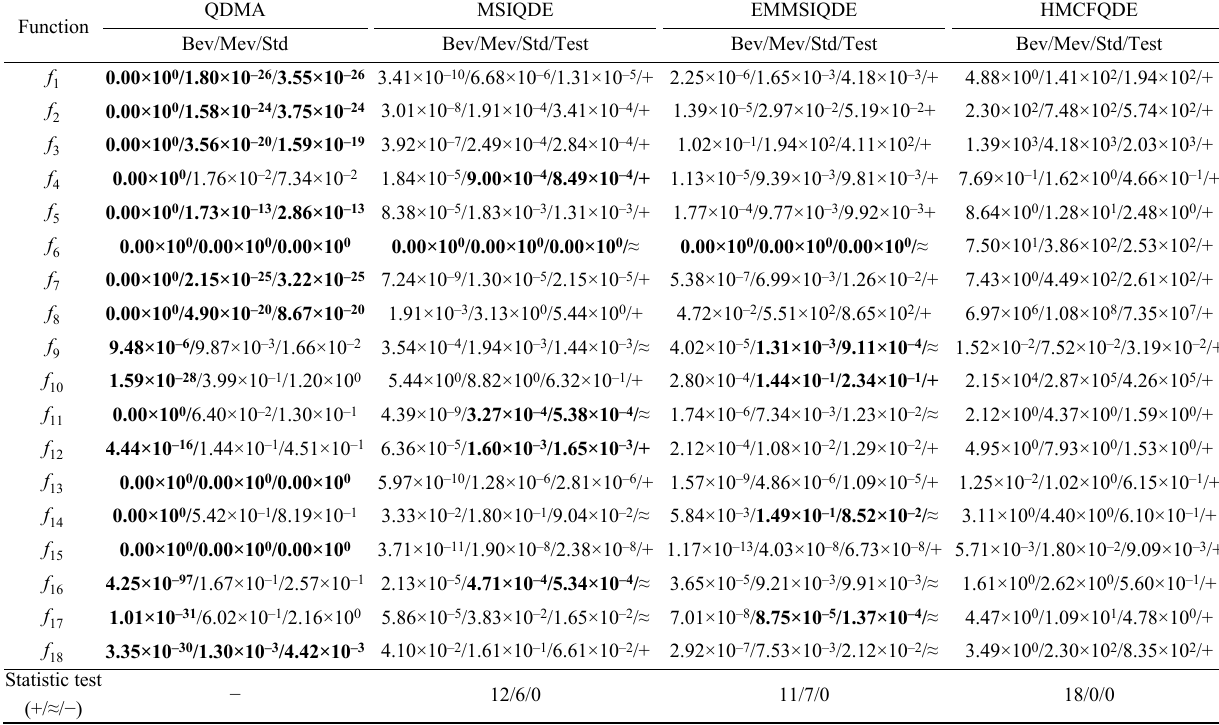
Table 1 Comparison of QDMA and state-of-the-art QEAs on 10 D